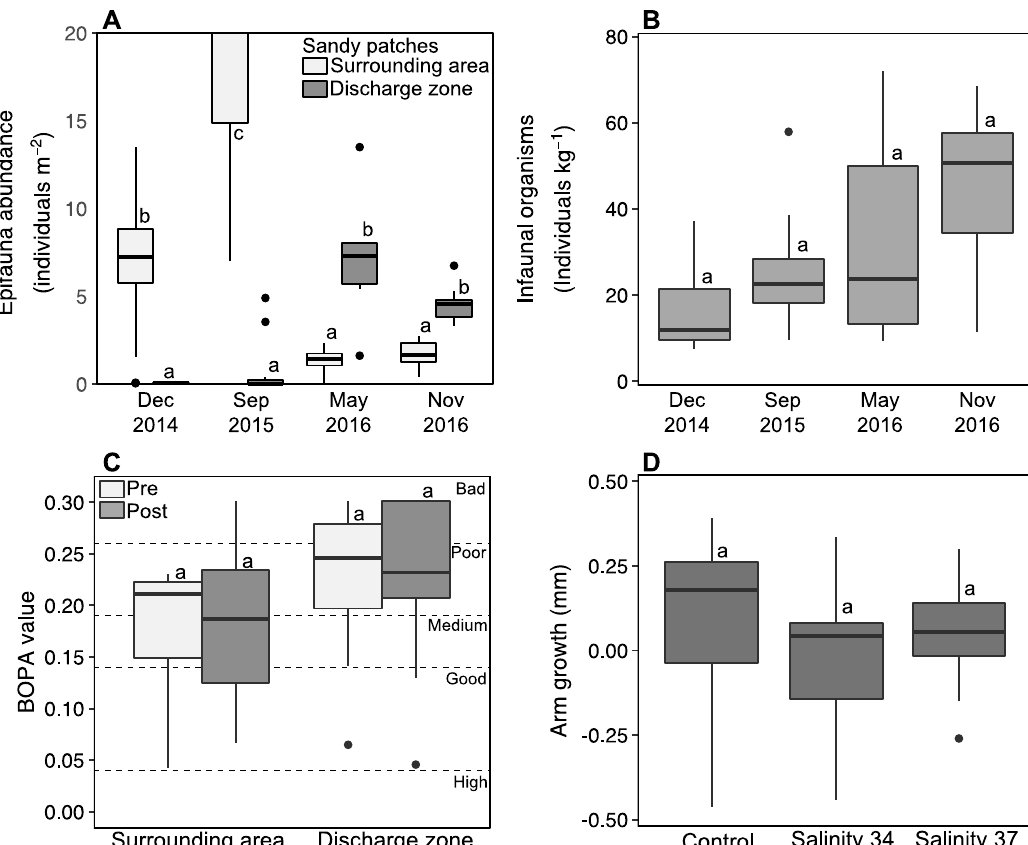
Figure 5. Box-whisker plots with significance letters above boxes refering to ANOVA followed by a Tukey-HSD test with significance of p < 0.05. ( A ) Median values for epifauna abundance in the immediate discharge zone (50–200 m from shore) and in the surrounding sandy areas (250–1000 m offshore), and ( B ) infaunal abundance in the area around the outfall channel (100–1000 m offshore) for pre-operation (December 2014 and September 2015) and post-operation (May and November 2016). Box-whiskers plot of ( C ) BOPA-values of pre- and post-operation at the sandy areas in the discharge zone (50–200 m from shore around the outfall) and in the surrounding sandy areas. The horizontal dashed lines indicating the ecological rank from good (high biodiversity) to bad (low biodiversity for mainly opportunistic species). Box-whiskers plot of the brittle stars’ arm growth ( D ) after five weeks of incubation in brine from the outfall of Carlsbad Desalination Plant.